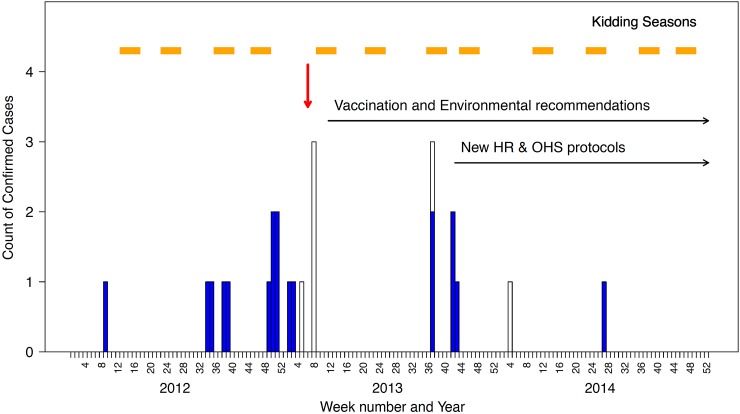
Epidemic curve of confirmed cases of Q fever linked to an outbreak associated with
a goat and sheep dairy farm in Victoria, 2012–2014. Light blue bars represent
confirmed cases, open bars are probable cases and the red arrow indicates when the
investigation was launched.